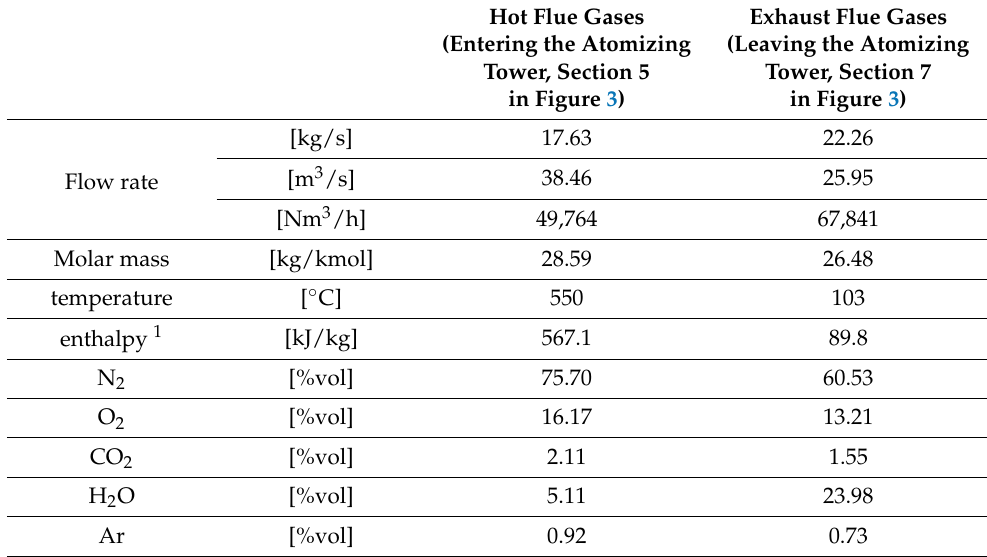
Table 4. Energy rate balance of ATM 110 spray dryer. Inlet Energy Rate [kW] Outlet Energy Rate [kW] Combustion air − 57 Pressurized air − 119 Natural